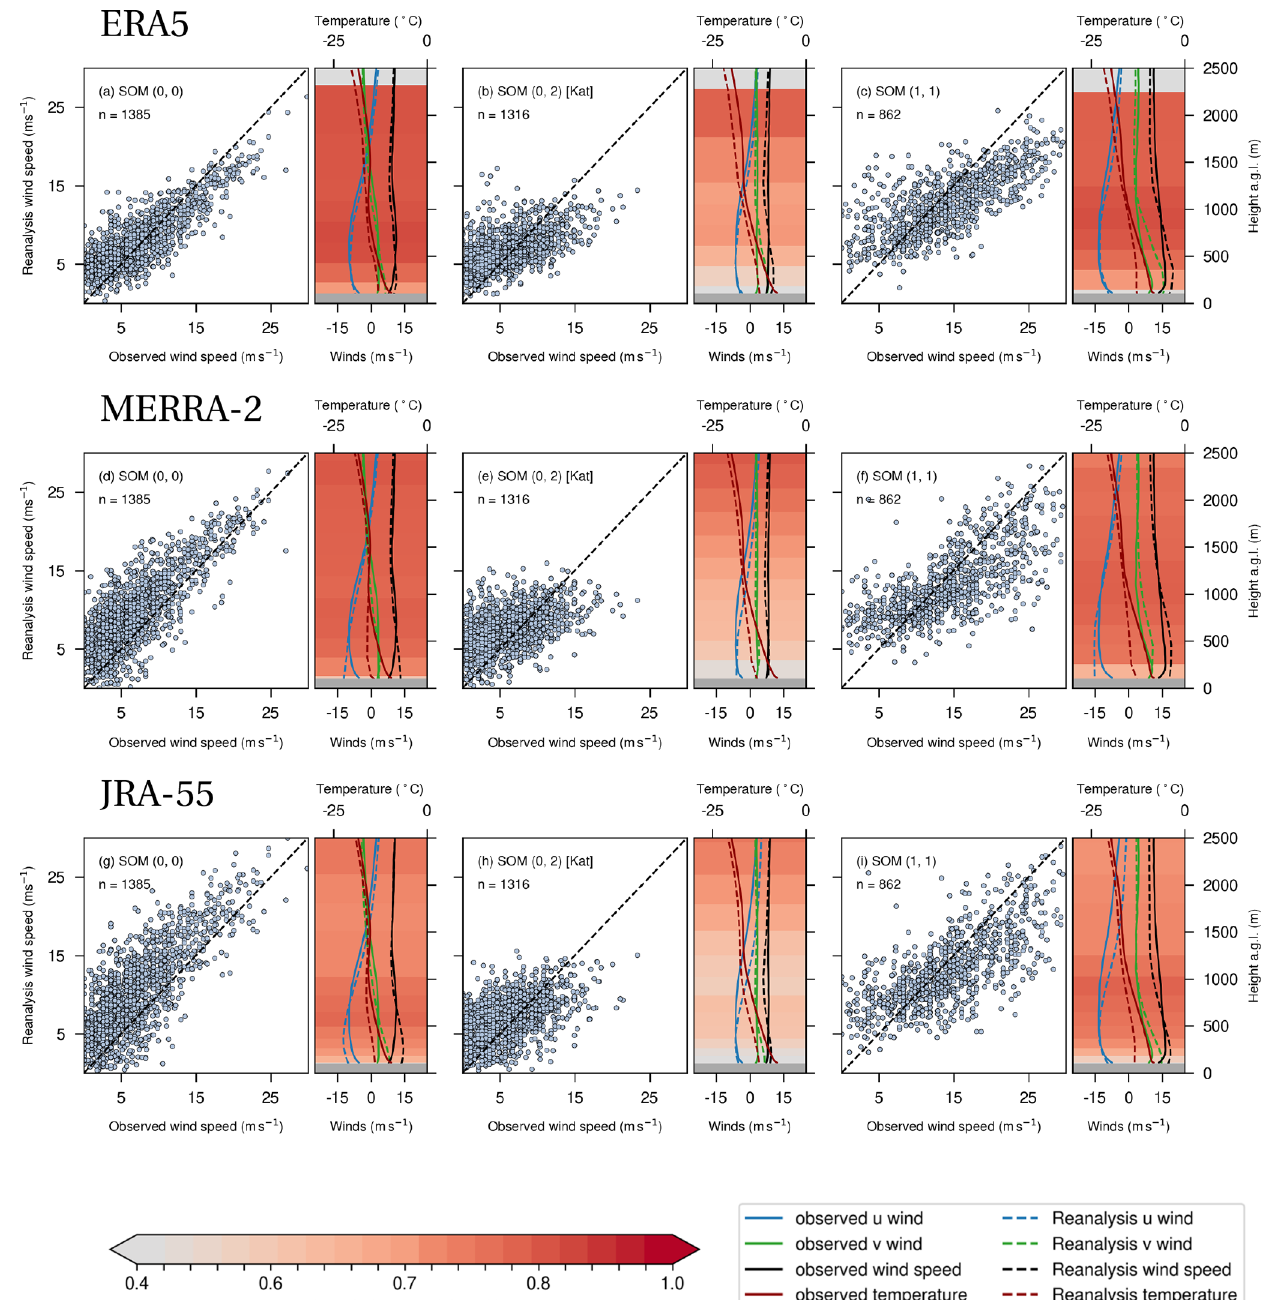
Figure 8. As in Fig. 7 but for DDU. All shaded correlation coefficients are significant at the 99% level, according to a two-sided t test. These three SOM nodes account for 68.5% of the total variability at